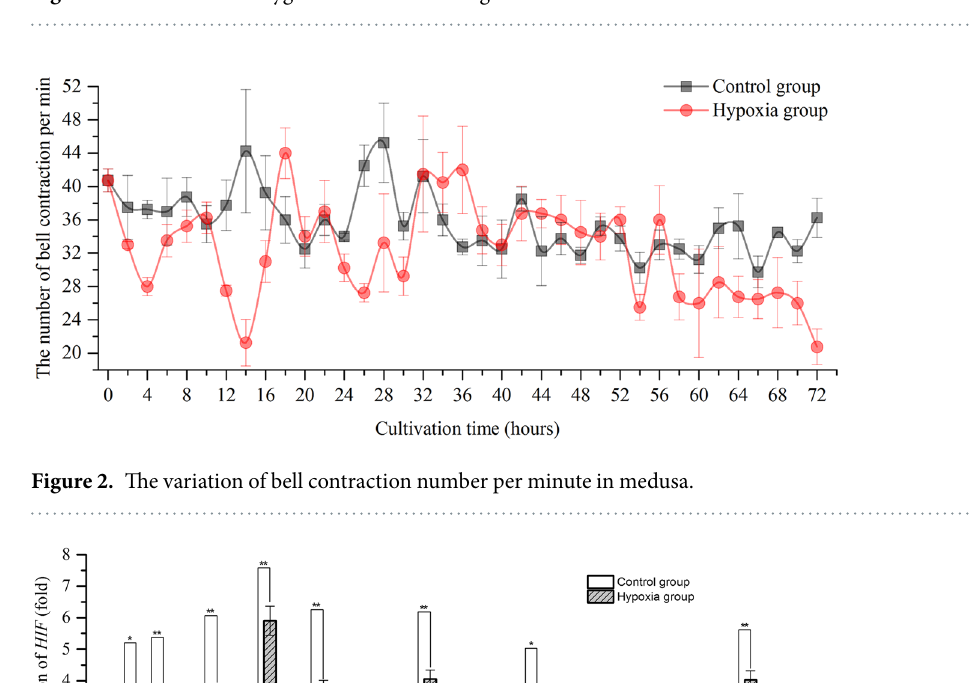
Figure 1. The dissolved oxygen concentration range.